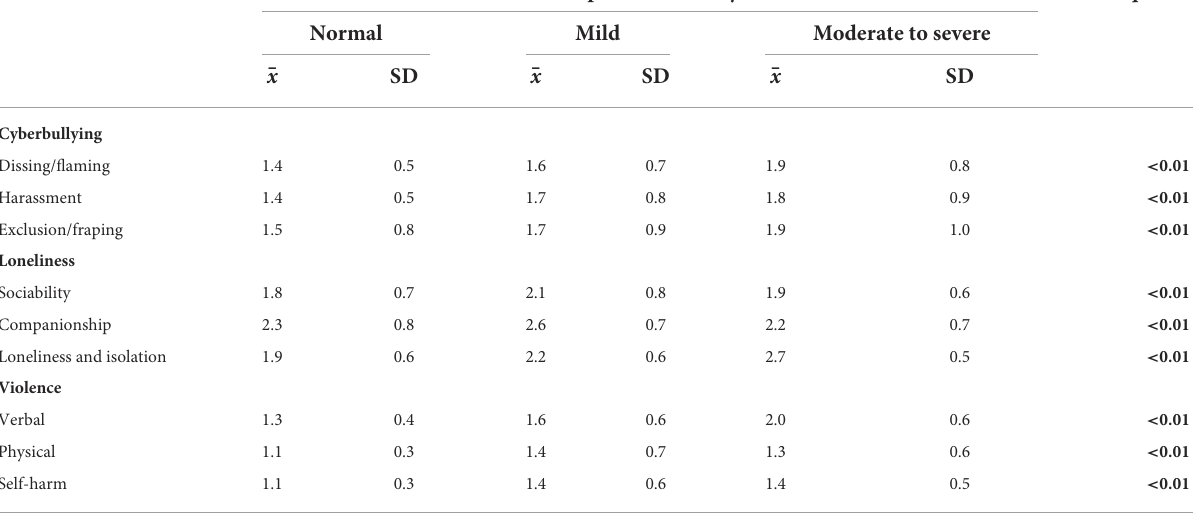
TABLE 3 Cyberbullying, loneliness, and violence among respondents.